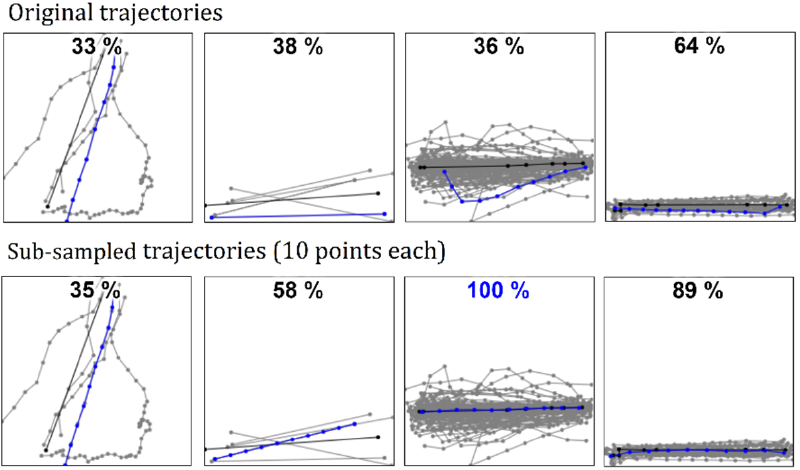
Figure 10. Selected examples of medoid with HC-SIM and LCSS similarity measures. Blue line is the average result, and black line is the ground truth.